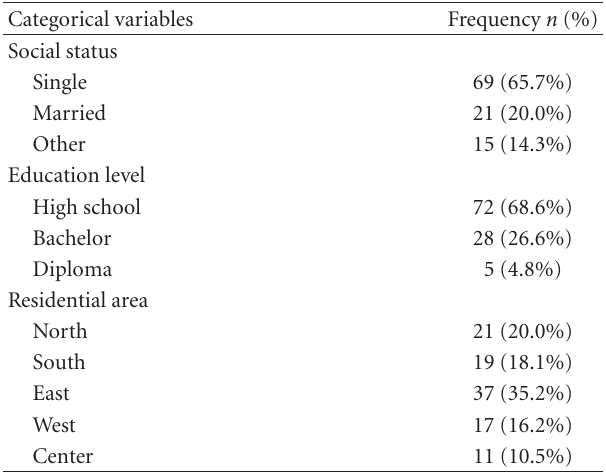
Table 2: Social status, education level, and residential area ( n = 105).